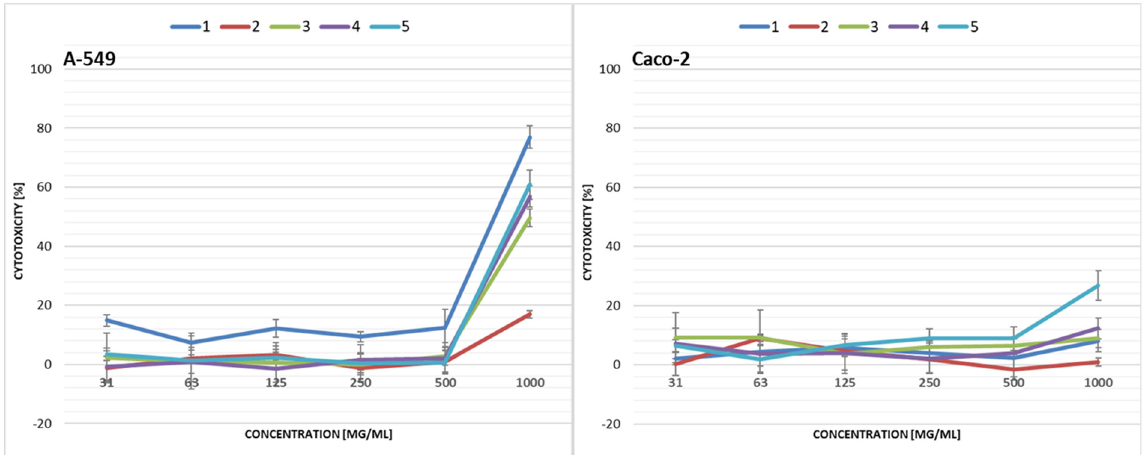
Figure 10. Cytotoxicity of soil extracts collected from the landfill in the PrestoBlue assay after 72 h exposure of A-549 lung and Caco-2 intestinal epithelial cells. Each data point represents the mean of the fluorescence values from the cells of the four replicates. Results are presented as mean ± SD.